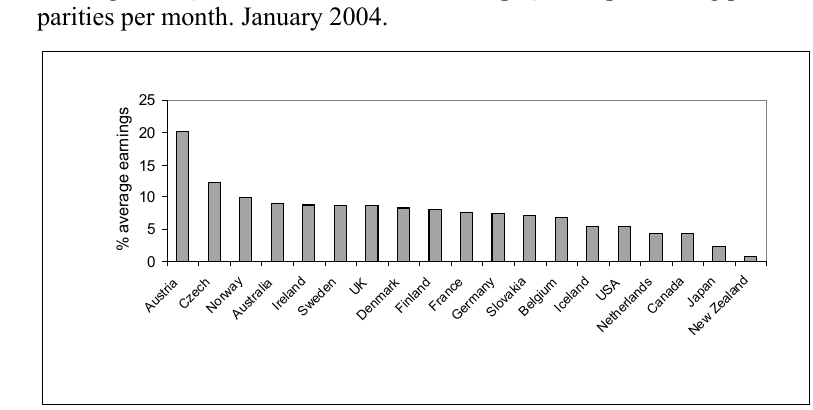
Figure 23 : Overall “average” child benefit package after taxes, benefits, childcare and housing costs (difference from childless couple) Euro purchasing power parities per month. January